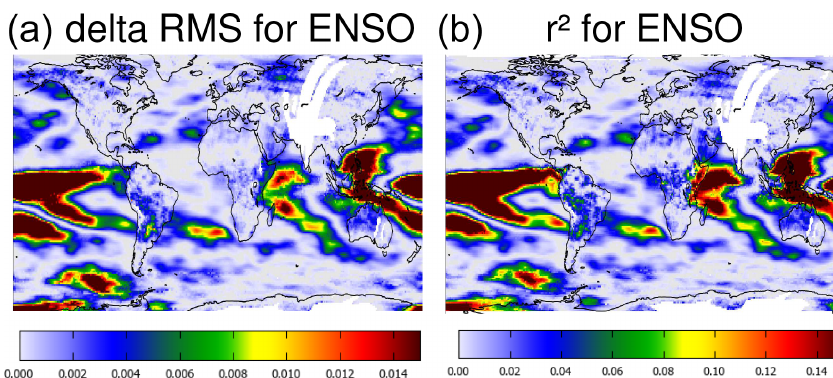
Figure A8. Delta rms (a) and r 2 values (b) for the fit of the ENSO index to the TCWV derived from satellite observations.